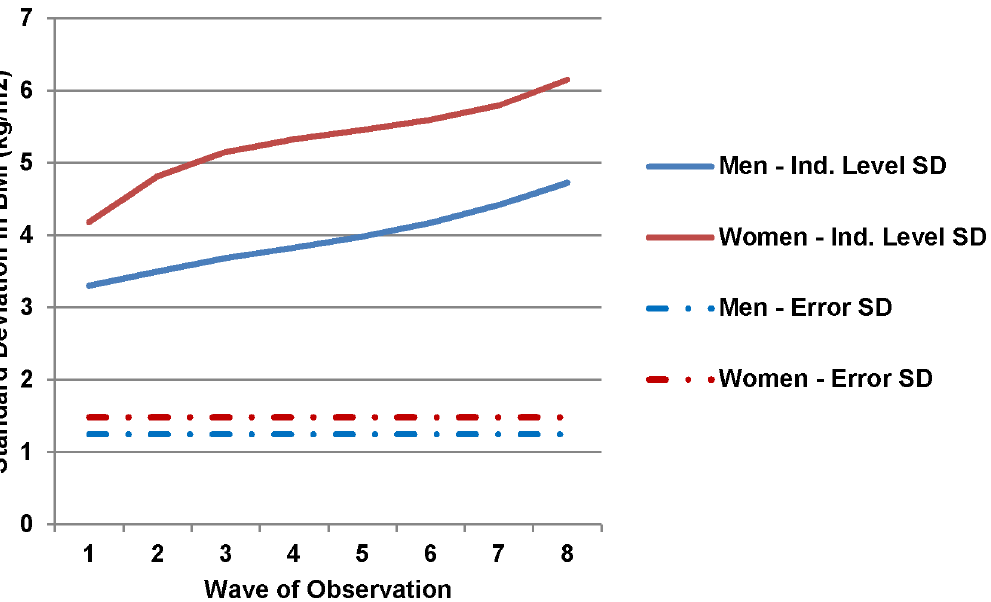
Figure 2. Adjusted Standard Deviation in Body Mass Index, Framingham Heart Study Offspring Cohort, 1971–2008. In the fully adjusted models, the total unexplained variation in BMI attributed to individuals across time (individual-level standard deviation) steadily increased from 1971 to 2008 for both women and men. The error standard deviation represents the idiosyncratic pure error variance. We accounted for non- linear increases in between-individual BMI standard deviation by including a random intercept at the individual level and random slopes for time and the natural log of time.